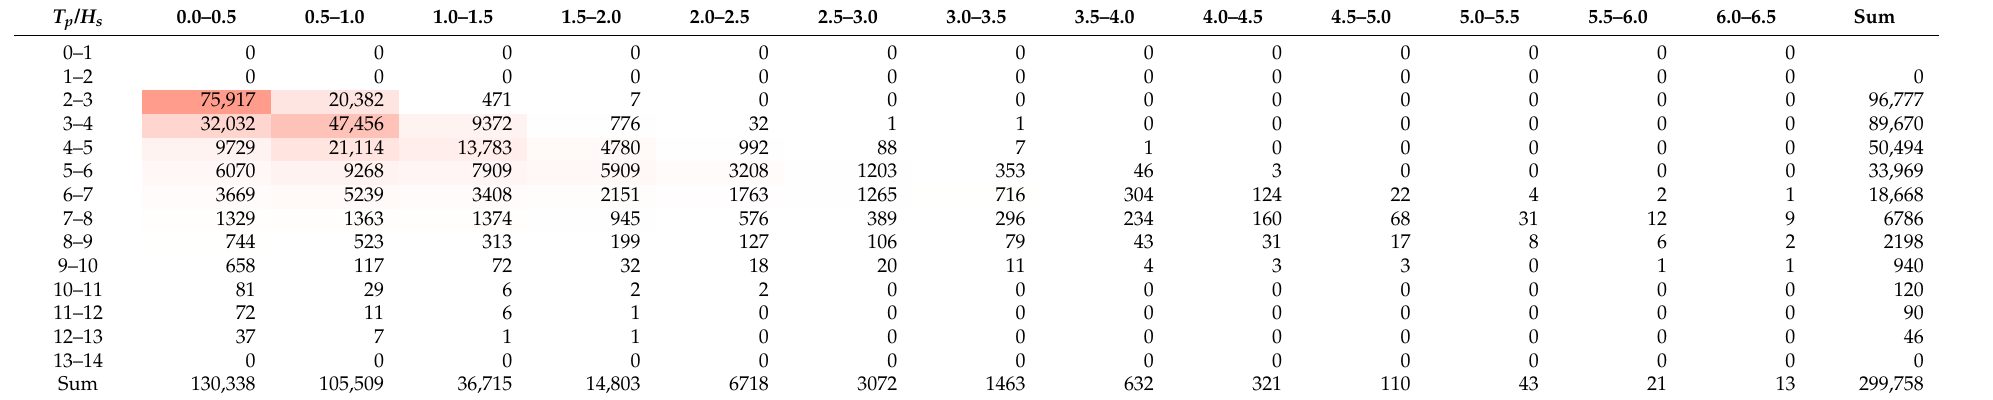
Table A4. Sea table for North Adriatic region (locations 1–9).